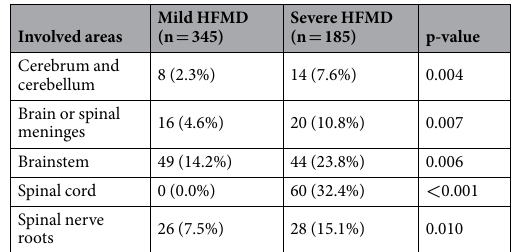
Table 2. Comparison of MRI findings between mild HFMD and severe HFMD. Note: HFMD = Hand-Foot- Mouth Disease; categorical variables were expressed as number of patients (percentage); Cerebrum and cerebellum include cerebral cortex, cerebral white matter, cerebellum, basal ganglia, callosum and thalamus;